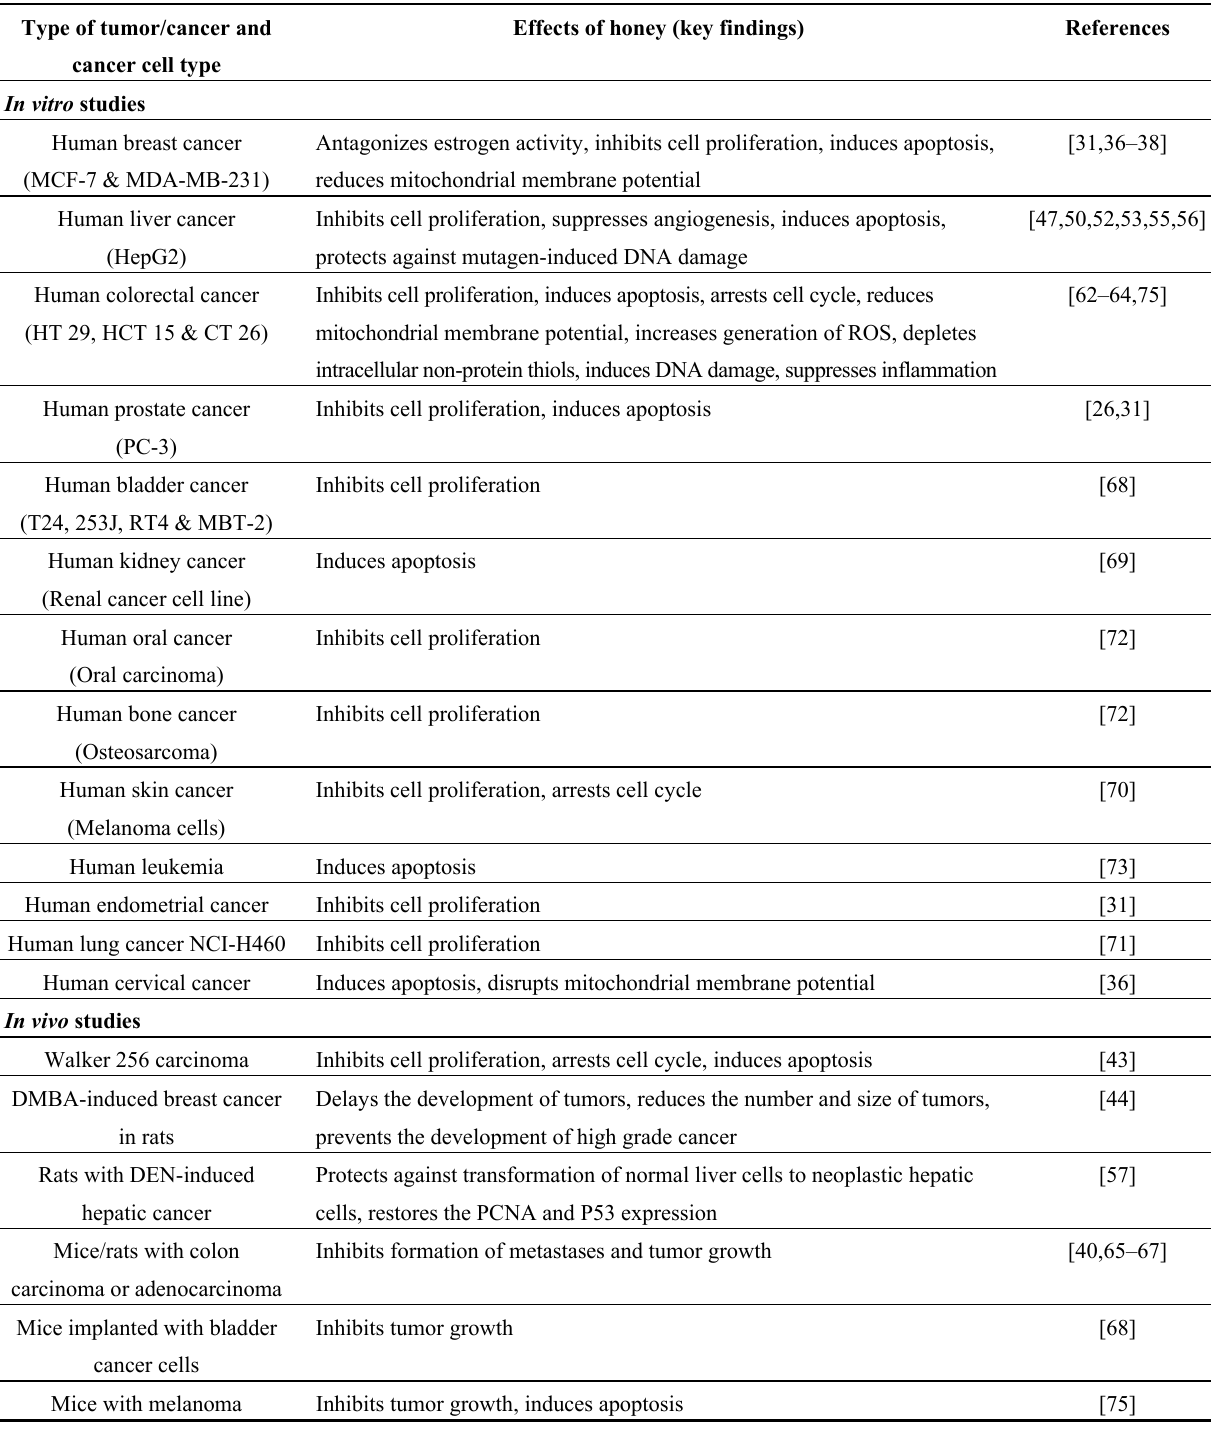
Table 1. Effects of honey on the development and progression of tumor and cancer cells. Type of tumor/cancer and cancer cell